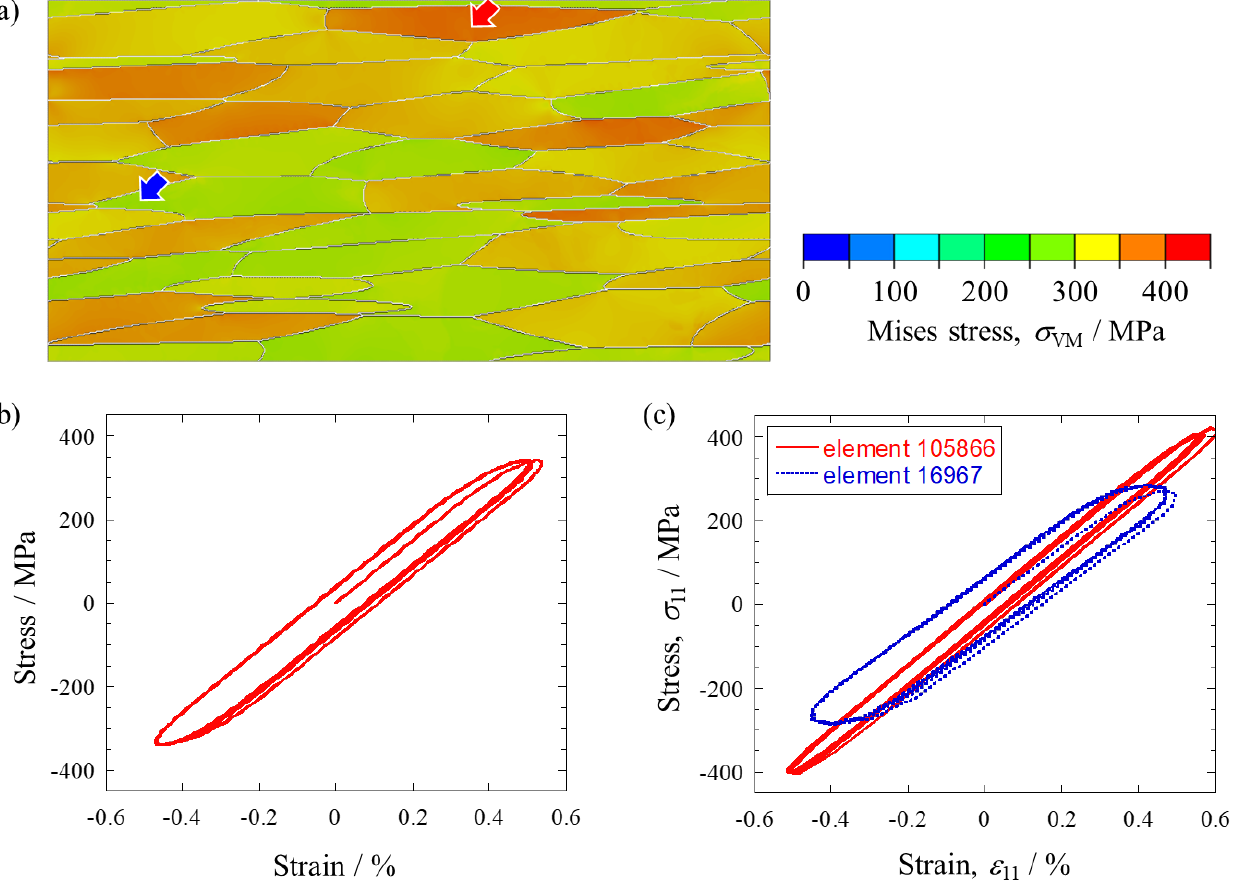
Figure 4. ( a ) Mises stress distribution at maximum stress applied ( σ max = 340 MPa, R = − 1). ( b ) Macroscopic stress-strain curve. ( c ) Stress-strain curves at the higher and lower stress locations indicated by arrows in ( a ).